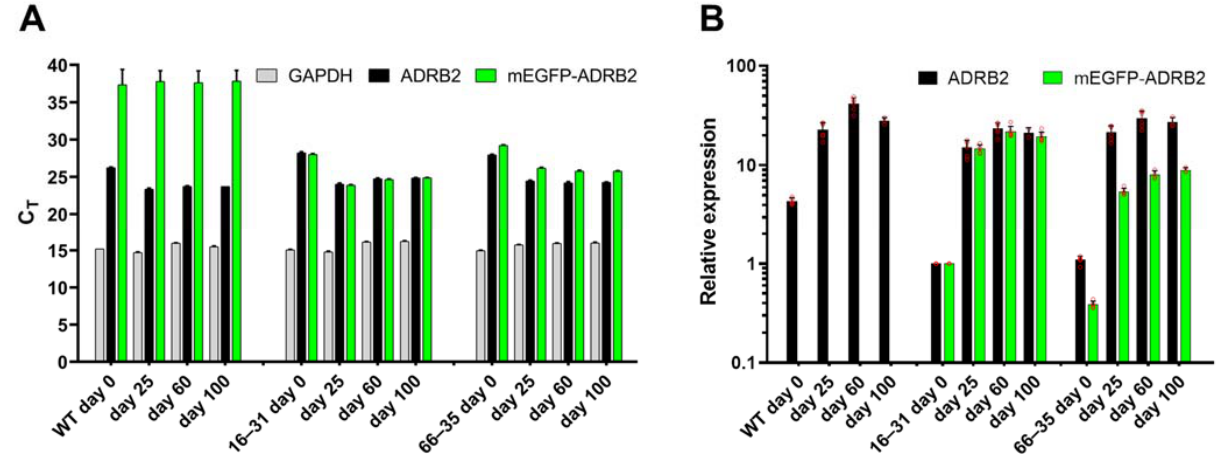
Figure 2. Indication of endogenous ADRB2 and mEGFP-ADRB2 mRNA expression during hiPSC-CM culture maturation. ( A ) Absolute cycle threshold (Ct) expression values for GAPDH , ADRB2 and mEGFP-ADRB2 are shown. ( B ) Relative expression of data shown in ( A ) normalized to GAPDH and calibrated to day 0 of clone 16–31. Data are mean ± SD of (3–6 replicates of) 2 independent experiments.